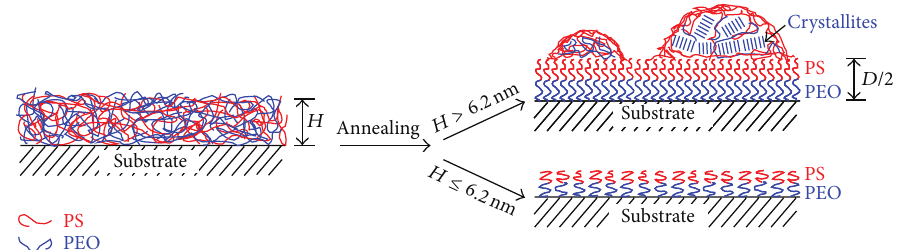
Figure 6: Schematic side view of the PEO- b -PS diblock copolymer with different initial thickness developed on the Si wafer under thermal annealing. A polymer brush was formed in the film of thickness less than 6.2 nm. When the film is thicker than 6.2 nm, a dense polymer brush equal to half of an interlamellar layer ( D /2) was formed, and the excess material dewets this layer to form droplets. The PEO block can crystallize to form spherulite in the bigger